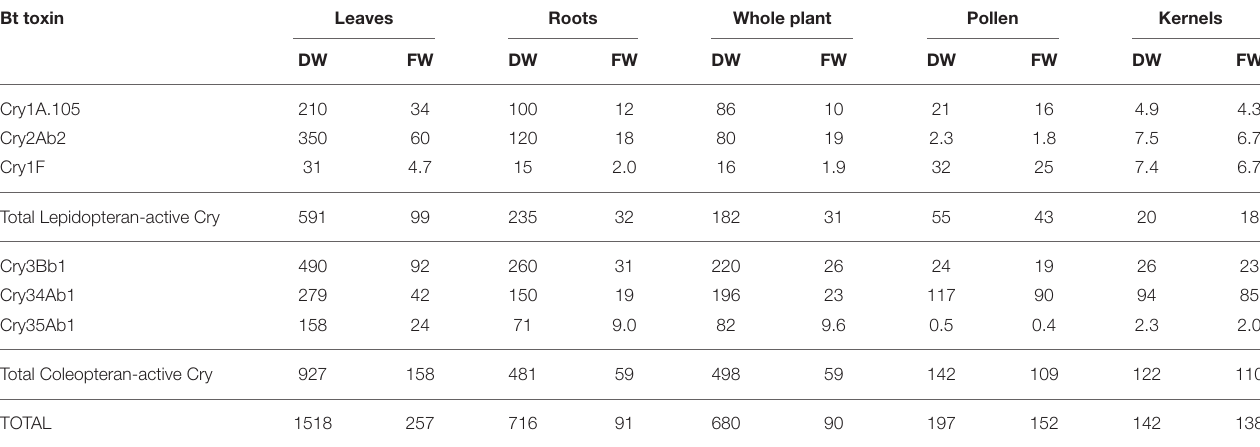
TABLE 1 | Maximum Cry toxin concentrations [ µ g/g] measured in field-grown SmartStax, several US locations in 2006 * ; FW, fresh weight; DW, dry weight. Bt